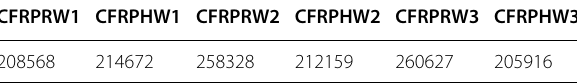
Table 2 Cumulative Energy Dissipation (kN